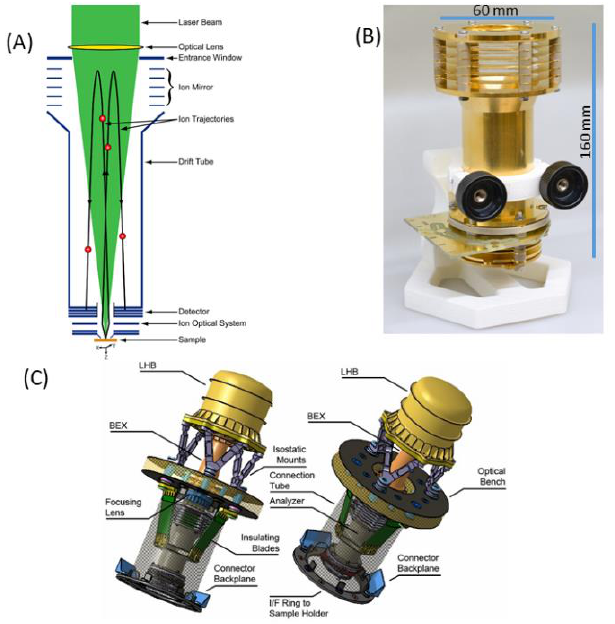
Figure 1. Schematic diagram of a miniature LMS with key parts labelled ( A ), an image of the mass analyser with its dimensions ( B ) and a possible design of a space instrument with an optical part (optical system with a microchip laser) attached to an optical bench (interface), introducing a focused laser radiation from the reflectron site ( C ).